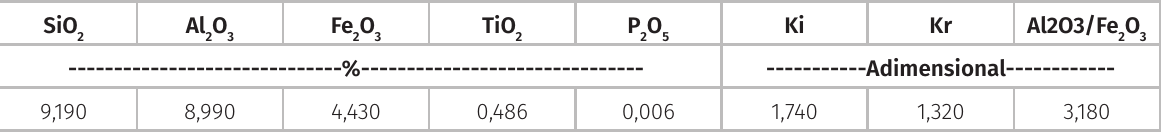
Table II. Mineralogical characteristics of the soil. SiO